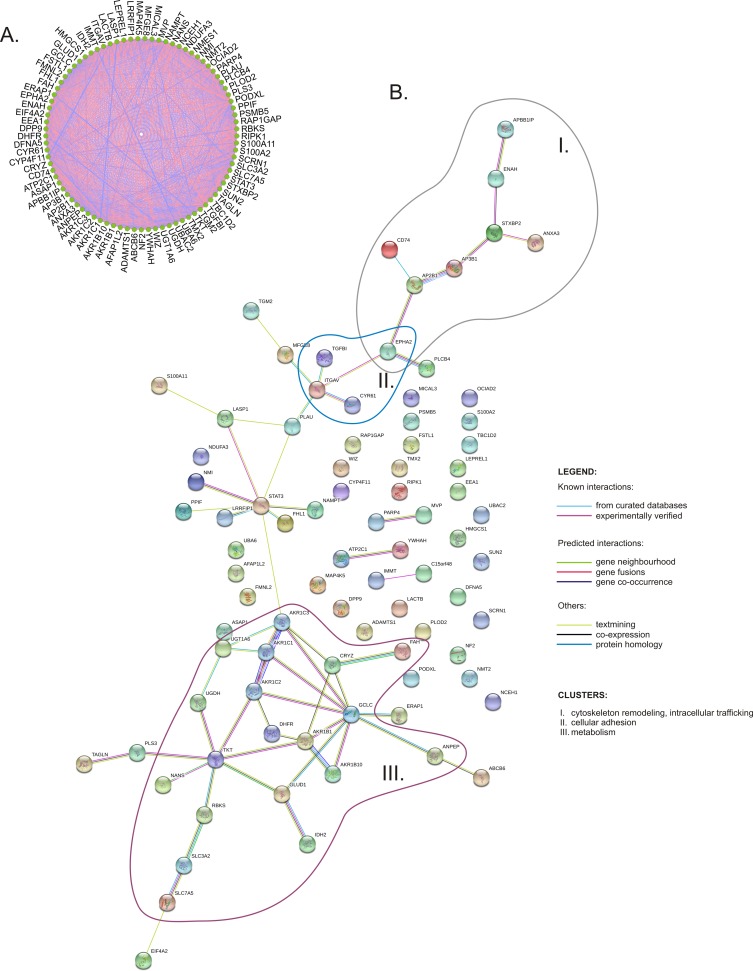
The network of proteins affected by DIO1 expression.A. Network of expression correlations; the proteomic data of protein expression levels were analyzed using Metscape/Cytoscape application. Blue lines: negative correlations, red lines: positive correlations. Thickness of lines indicates strength of correlations. B. Protein interaction network generated with STRING v. 10.5 accessed on 2017.11.06. with default settings (minimum required interaction score: medium confidence 0.4). Three major clusters are labelled as I (cytoskeleton remodeling and intracellular trafficking), II (cellular adhesion), and III (metabolism).